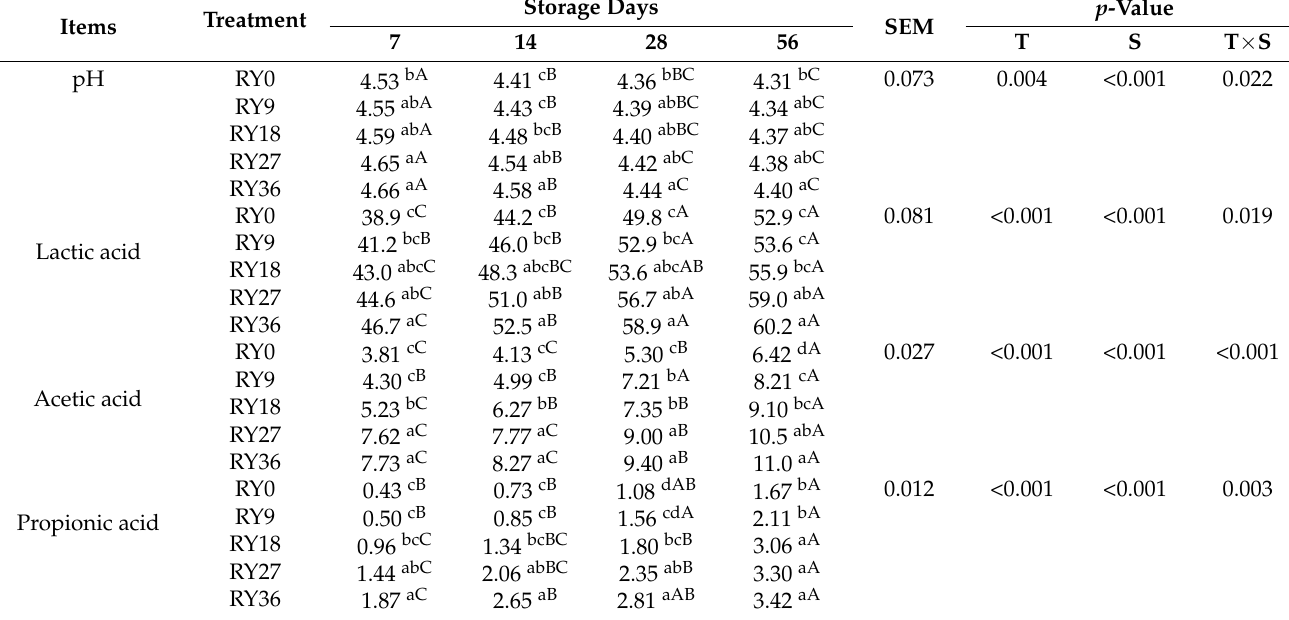
Table 3. Effect of paper mulberry replacement levels and storage days on fermentation quality of TMR silages (g/kg DM). Items